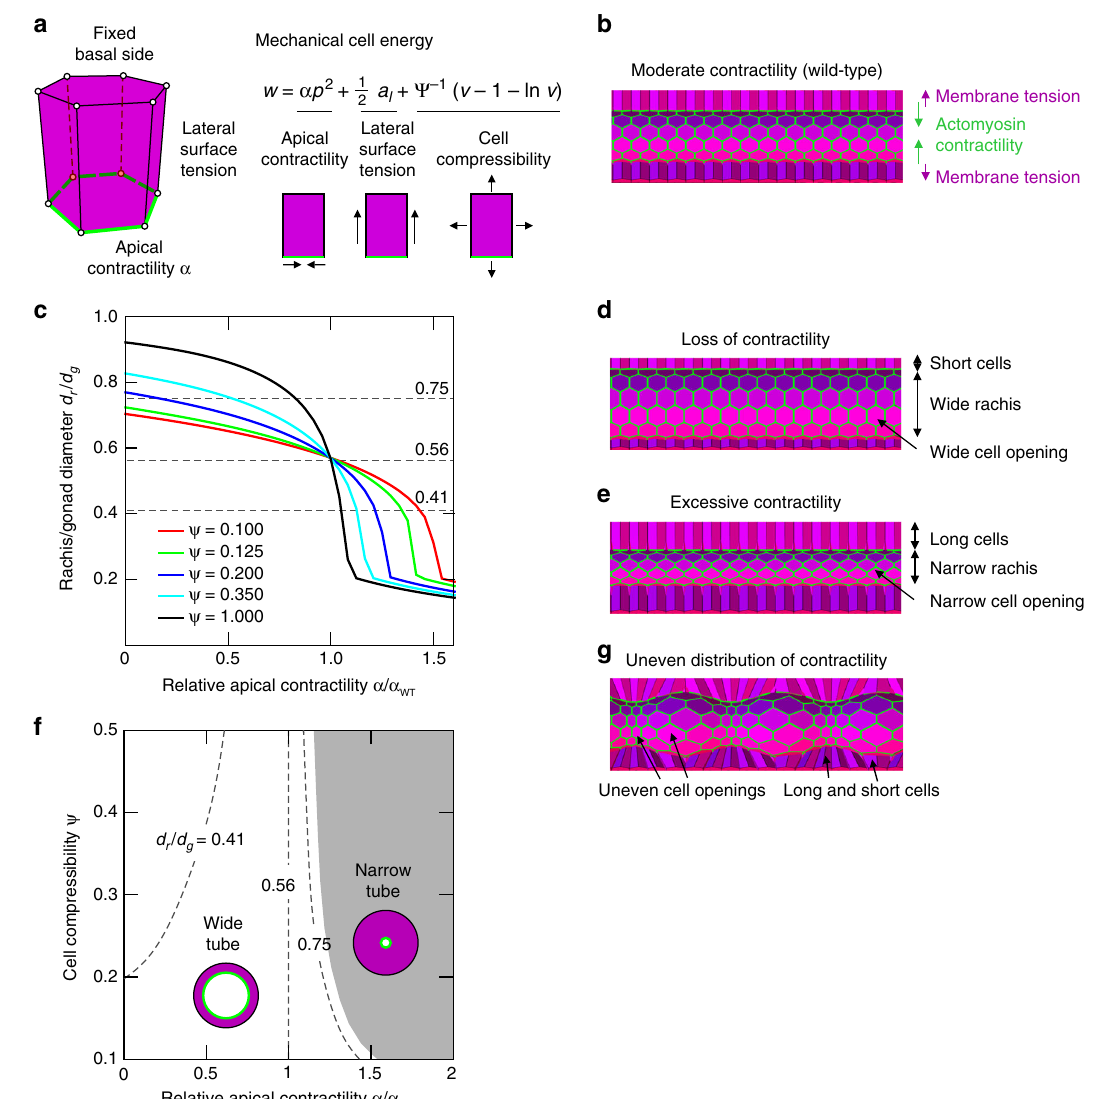
Fig. 7 Mathematical model encapsulating the idea that syncytial germline architecture is regulated by contractile tension at the apical end of germ cells. a A three-dimensional computational model of the germline is based on 3D vertex model, where individual cells are modeled as polyhedral bodies with a polygonal base and apex. Forces were calculated from the prescribed potential energy w , which includes tension contributions from lateral cell surfaces, apical contractility, and cell compressibility. b Simulated germline tube morphologies at equilibrium for apical contractility α = 0.242 at fi xed compressibility, ψ = 0.38. c Rachis diameter relative to the gonad diameter d r / d g at equilibrium as a function of the relative apical contractility α / α WT (where α WT is apical contractility for wild type) is shown for varying values of cell compressibility ψ . The dashed lines at d r / d g = 0.75, 0.56, and 0.41 correspond for the three distinct phenotypical morphologies. d Simulated germline tube morphologies at equilibrium for apical contractility α = 0.121 at fi xed compressibility, ψ = 0.38. e Simulated germline tube morphologies at equilibrium for apical contractility α = 0.2701 at fi xed compressibility, ψ = 0.38. f Morphological phase diagram of the model tubular epithelium exhibits two distinct regimes: wide-tube and narrow-tube morphologies. Isolines connect morphologies that correspond to the experimentally measured average rachis diameters from cyk-1 /formin mutant ( dr/dg = 0.75), wild-type ( dr/dg = 0.56) and mel-11(RNAi) ( dr/dg = 0.41) worms. g Equilibrium tube morphology observed for an imposed contractile modulation along the apical boundary along the tube ’ s axis for fi xed compressibility, ψ = 0.38. The imposed modulation is 0.5 α WT sin (2 π z / λ ), where z is the longitudinal coordinate of the tube and λ is the tube ’ s